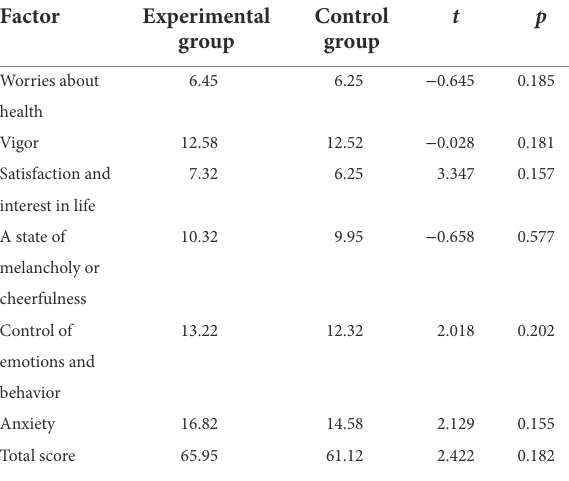
TABLE 12 The well-being scale of the experimental group and the control group after the experiment.